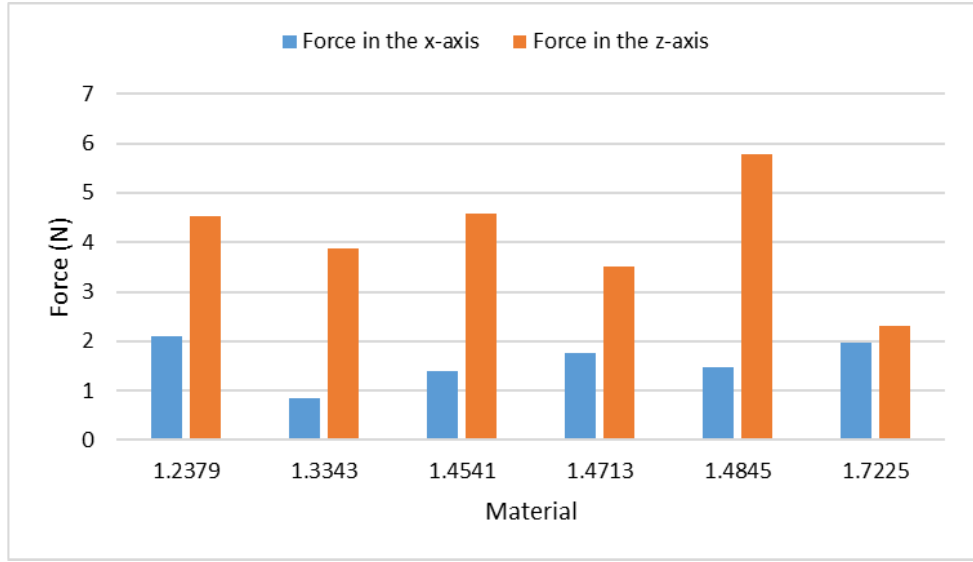
Figure 5. Measured forces at the traverse speed 40 mm/min on selected steels.